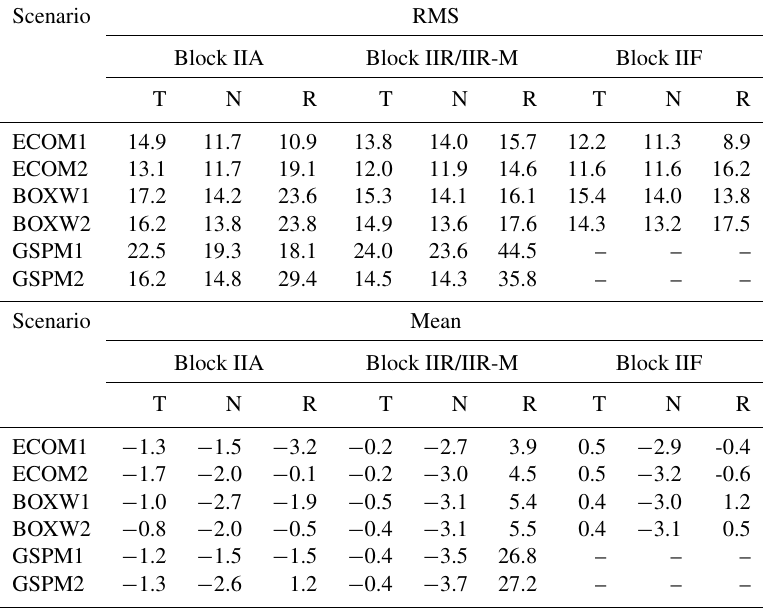
Table 1. The RMS and average value of orbit differences between operational IGS final products and different scenarios for Block IIA, IIR/IIR-M and IIF in along-track (T), cross-track (N) and radial (R) directions (unit: